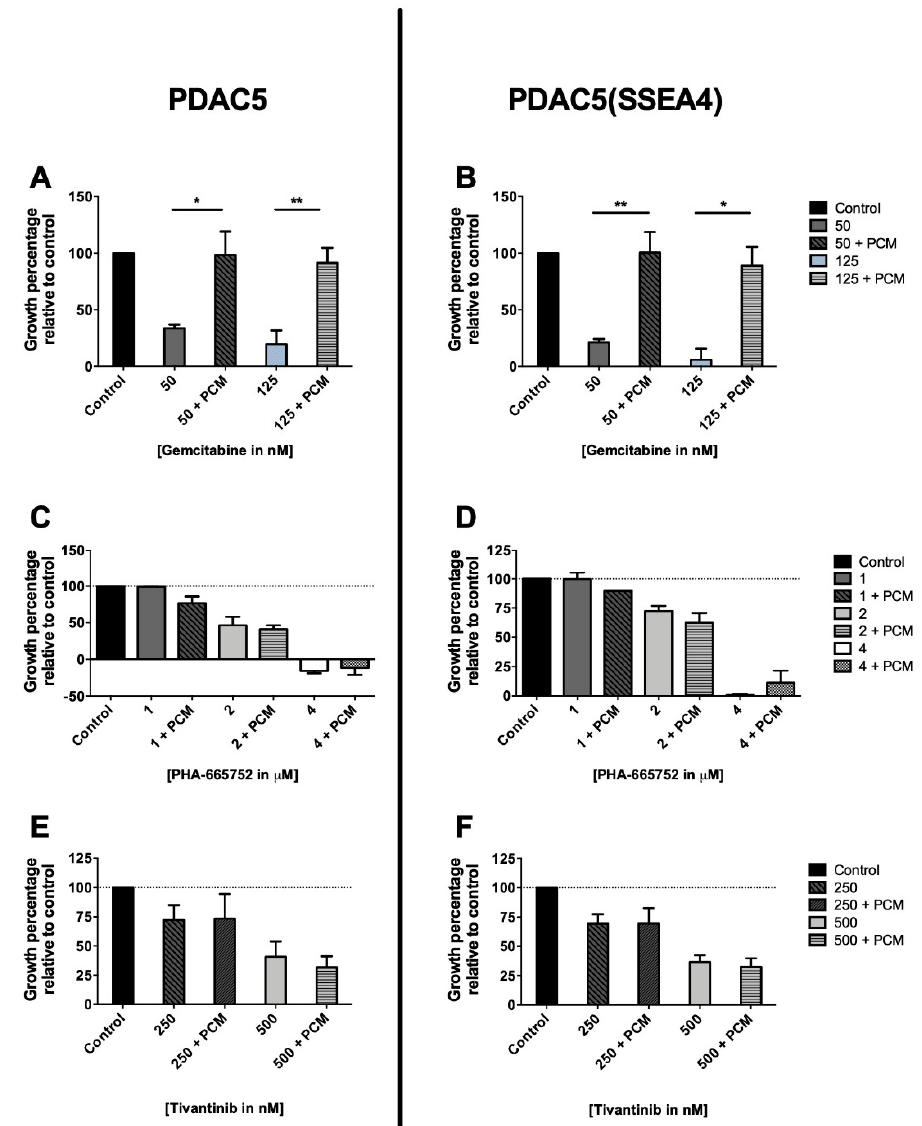
Figure 3. Effect of stimulated PSC conditioned medium on drug response in primary PDAC cells grown in monolayer culture assessed by sulforhodamine B (SRB) assay. PDAC5 and PDAC5 cells sorted for SSEA4 (PDAC5 (SSEA4)) were seeded in 96-well flat-bottom microplates and after incubation at 37 °C overnight, were treated with different drug concentrations in